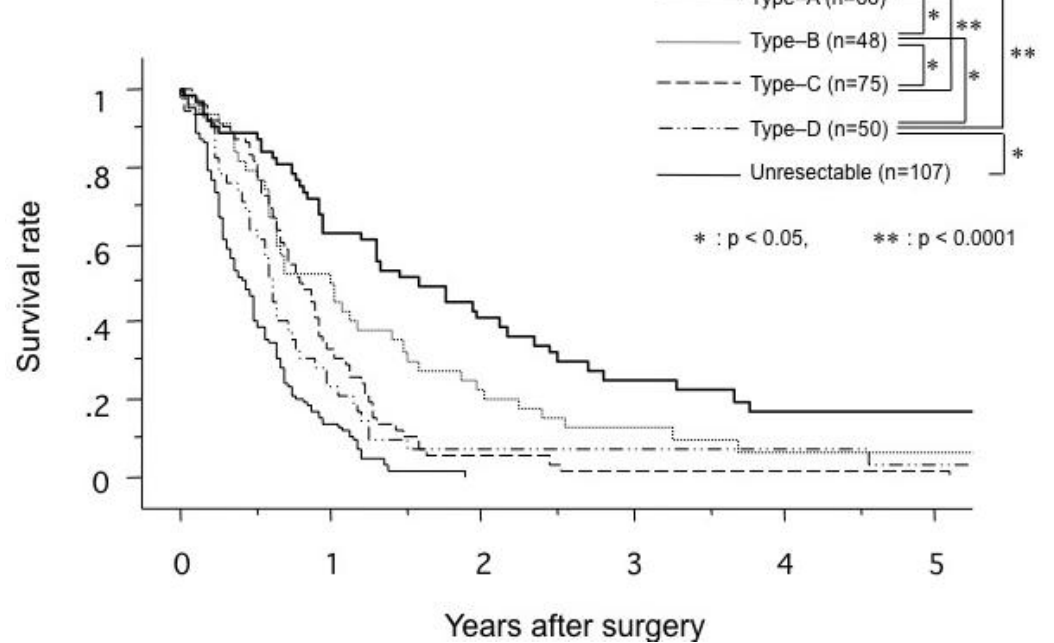
Figure 8. Comparison of cumulative survival rates according to the angiographic type of portography in patients with carcinoma of the pancreatic head. Type A, normal; type B, unilateral narrowing; type C, bilateral narrowing; type D, marked stenosis or obstruction with collateral veins (from [19]).